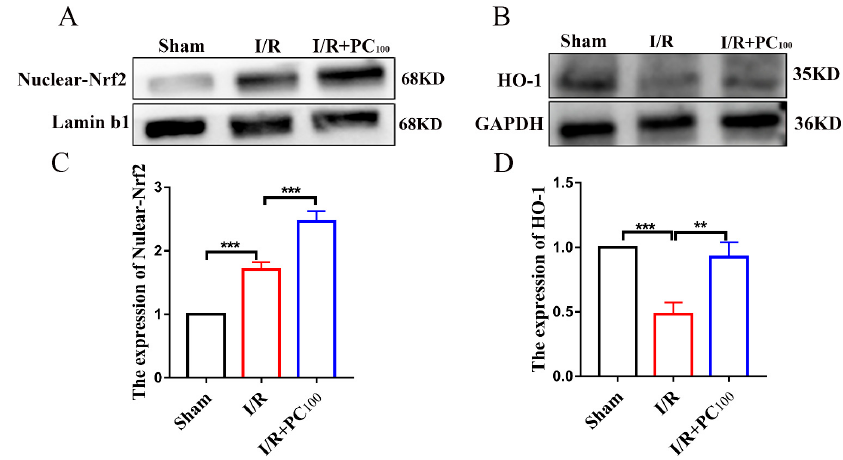
Figure 4. Effects of procyanidins on the Nrf2/HO-1 pathway. ( A − D ) The expression of Nuclear-Nrf2 and HO − 1 in the brain tissue of mice with CIRI (n = 3). All values are expressed as mean ± SD. n.s: no significant difference, ** p < 0.01, *** p < 0.001.